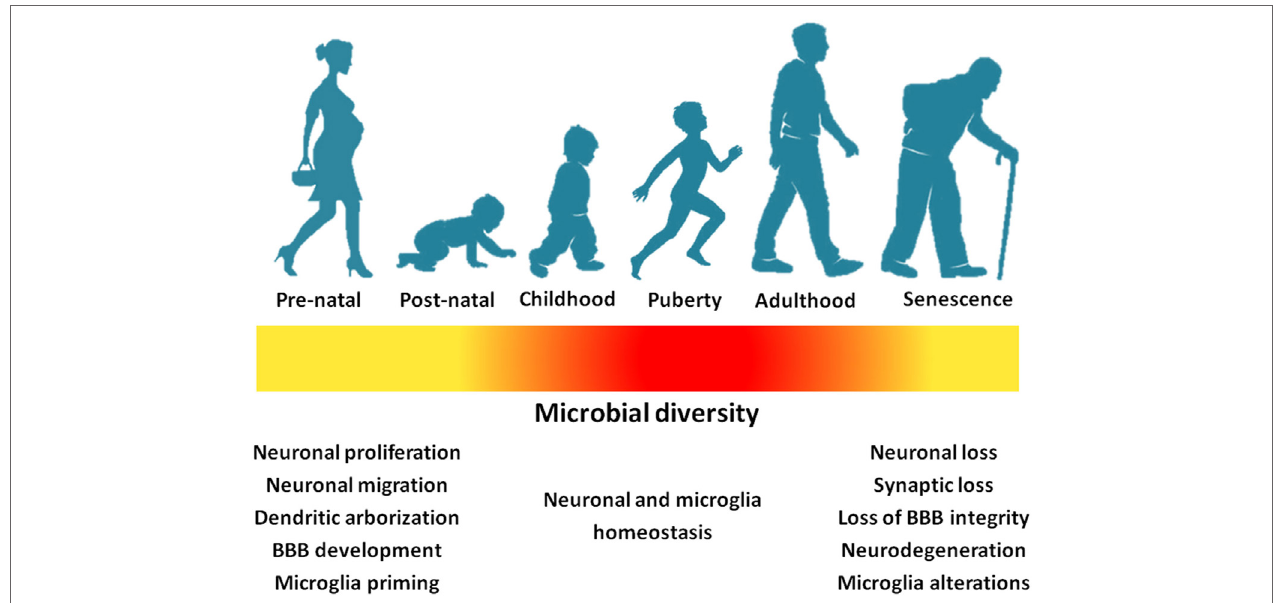
FiGURe 3 | Gut microbial richness and diversity across life stages impact neurodevelopment and the central nervous homeostasis (yellow: low richness/diversity; red: high richness/diversity). Abbreviation: BBB, blood–brain barrier.